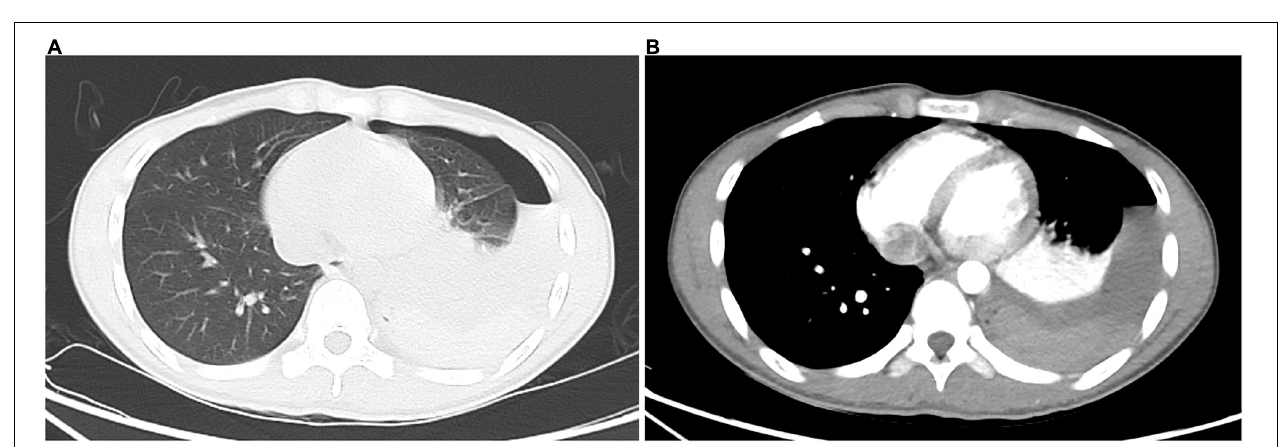
FIGURE 1 | Chest X-ray. (A) Left pneumothorax volume of approximately 30%. (B) Left pneumothorax with massive pleural effusion.